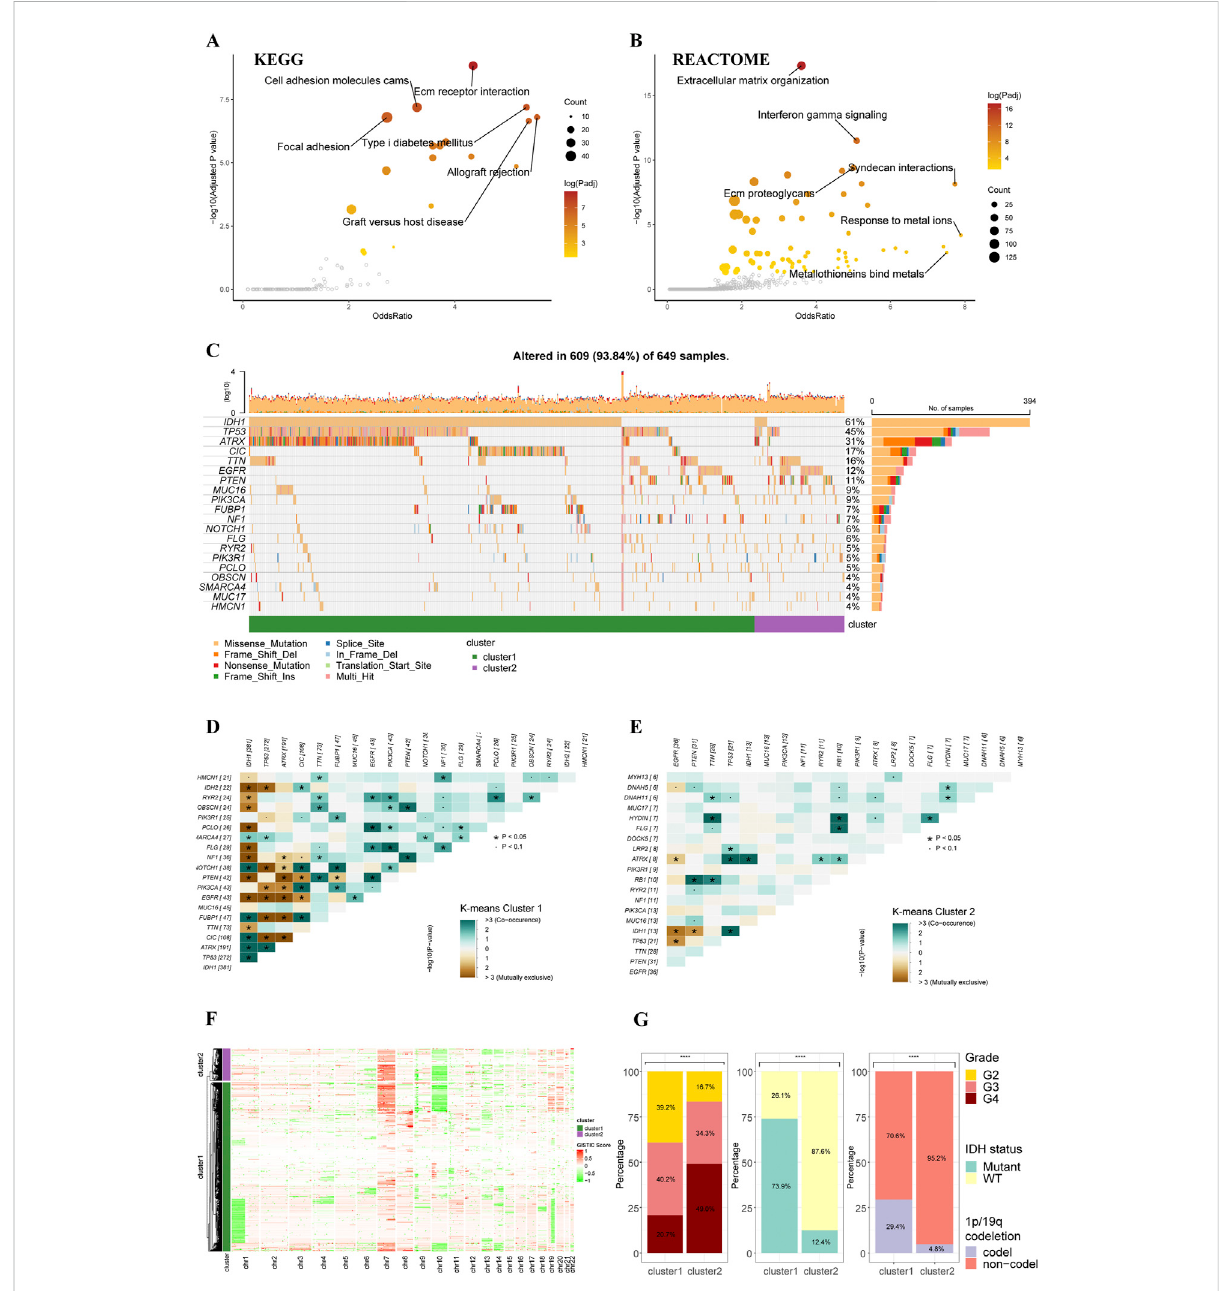
FIGURE 2 Functional enrichmentandclinicopathologicalfeaturesoftheK-meansclusters. (A) Pathwayswithhighoddsratioandcon fi denceintheKEGG gene sets. (B) Pathways with high odds ratio and con fi dence in the REACTOME gene sets. (C) Top 20 mutated genes of the K-means clusters. (D,E) Co-occurrence and mutually exclusive of the gene mutations in cluster 1 (D) and cluster 2 (E) . (F) Heatmap of copy number variations of the two clusters. (G) The difference in tumor grade, IDH mutation, and 1p/19q codeletion between two K-means clusters (cluster 1: N = 556, cluster 2: N =